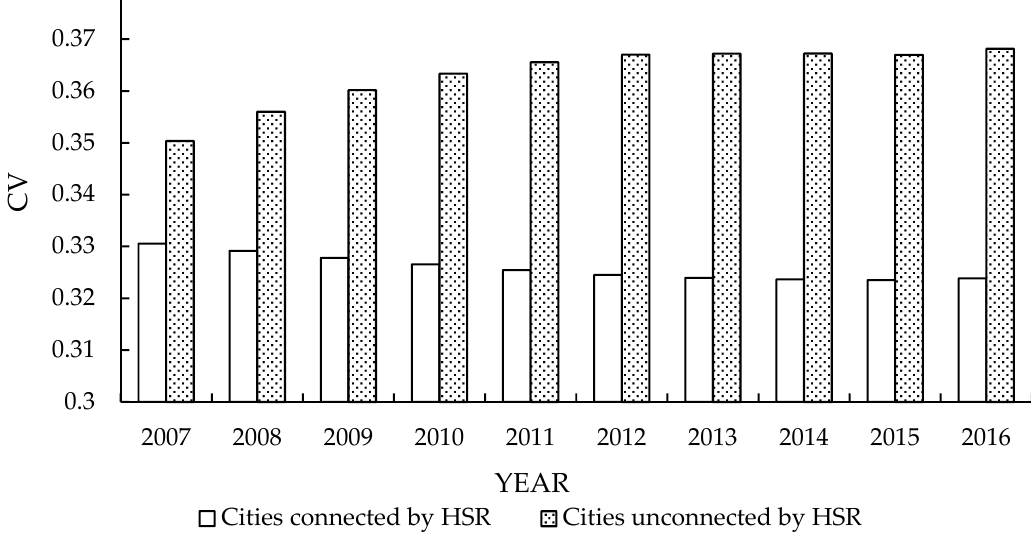
Figure 2. Average annual equalization of medical and health services.